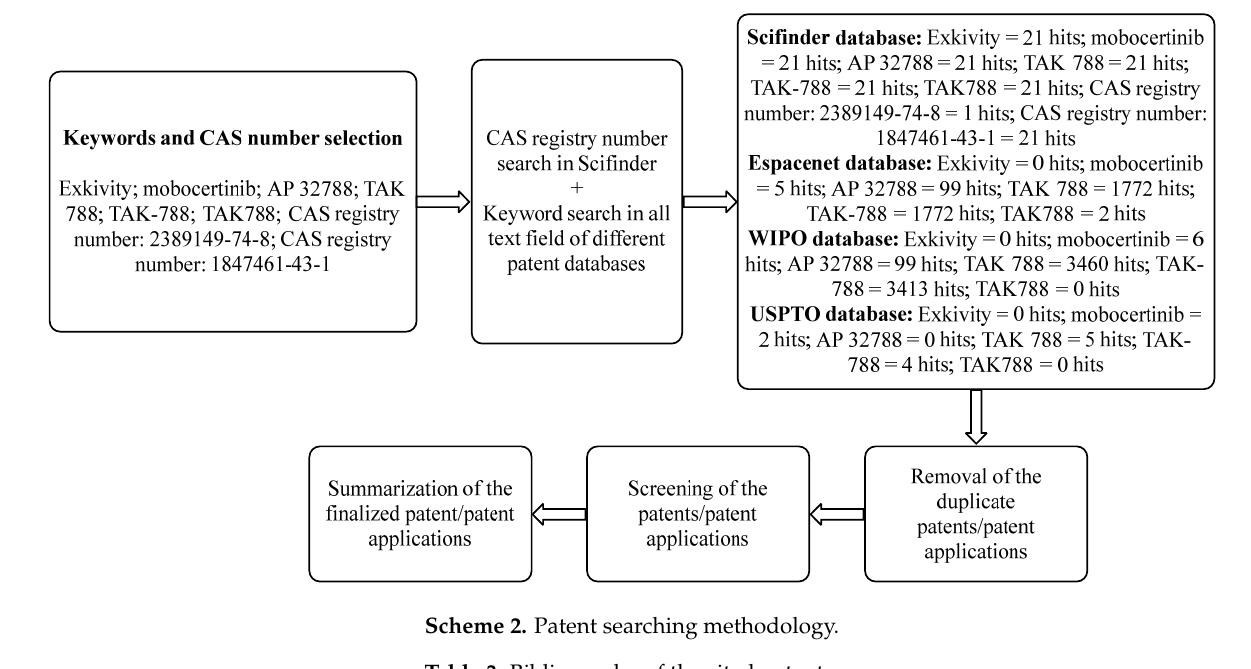
Table 3. Bibliography of the cited